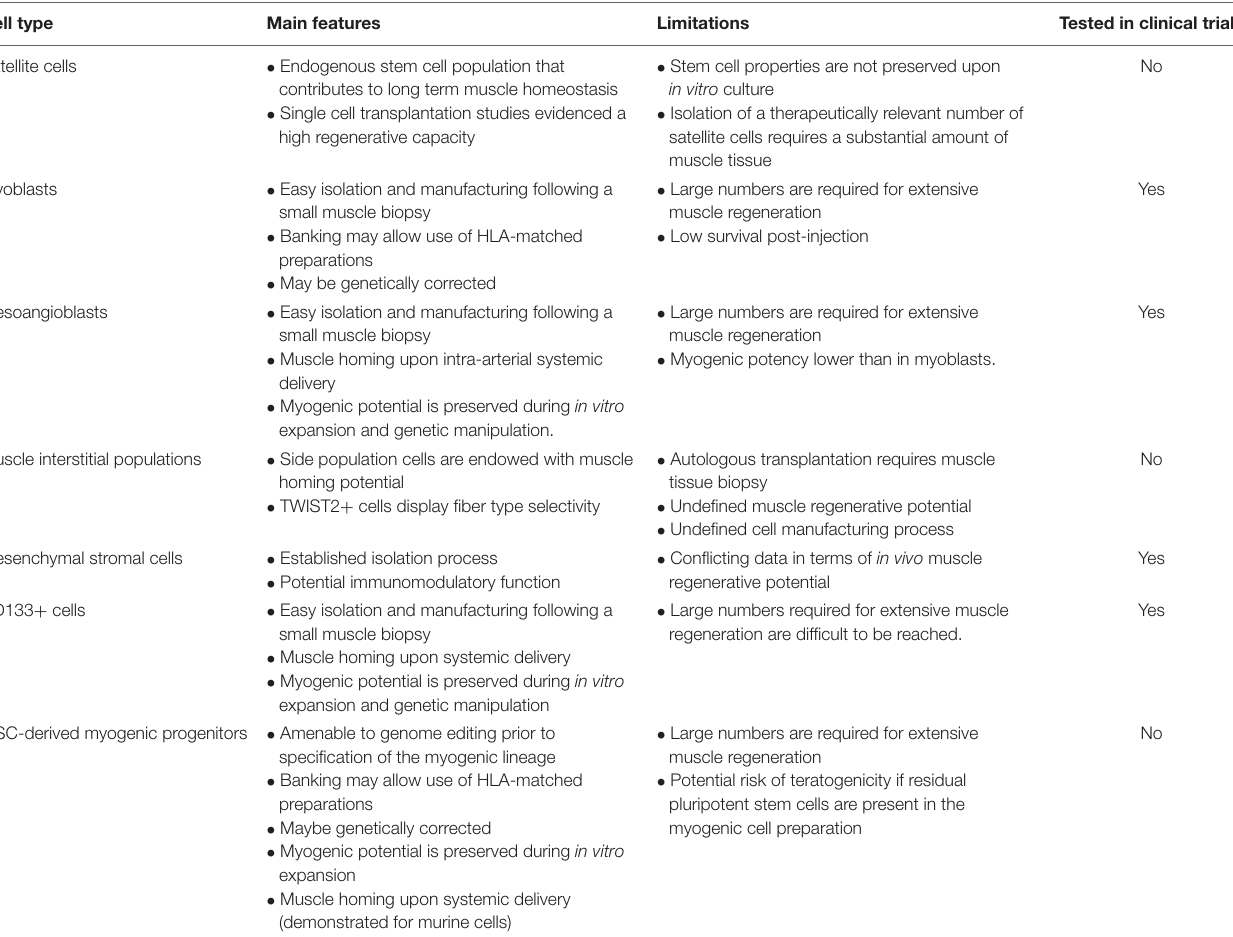
TABLE 1 | A simplified scheme of most common cell types used for transplantation, with features, limitations and current use in